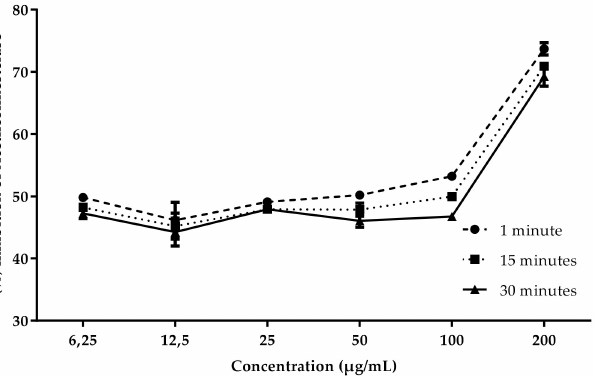
Figure 3. Concentration-dependent AChE inhibitory activity of methanolic extract of A. squamosa